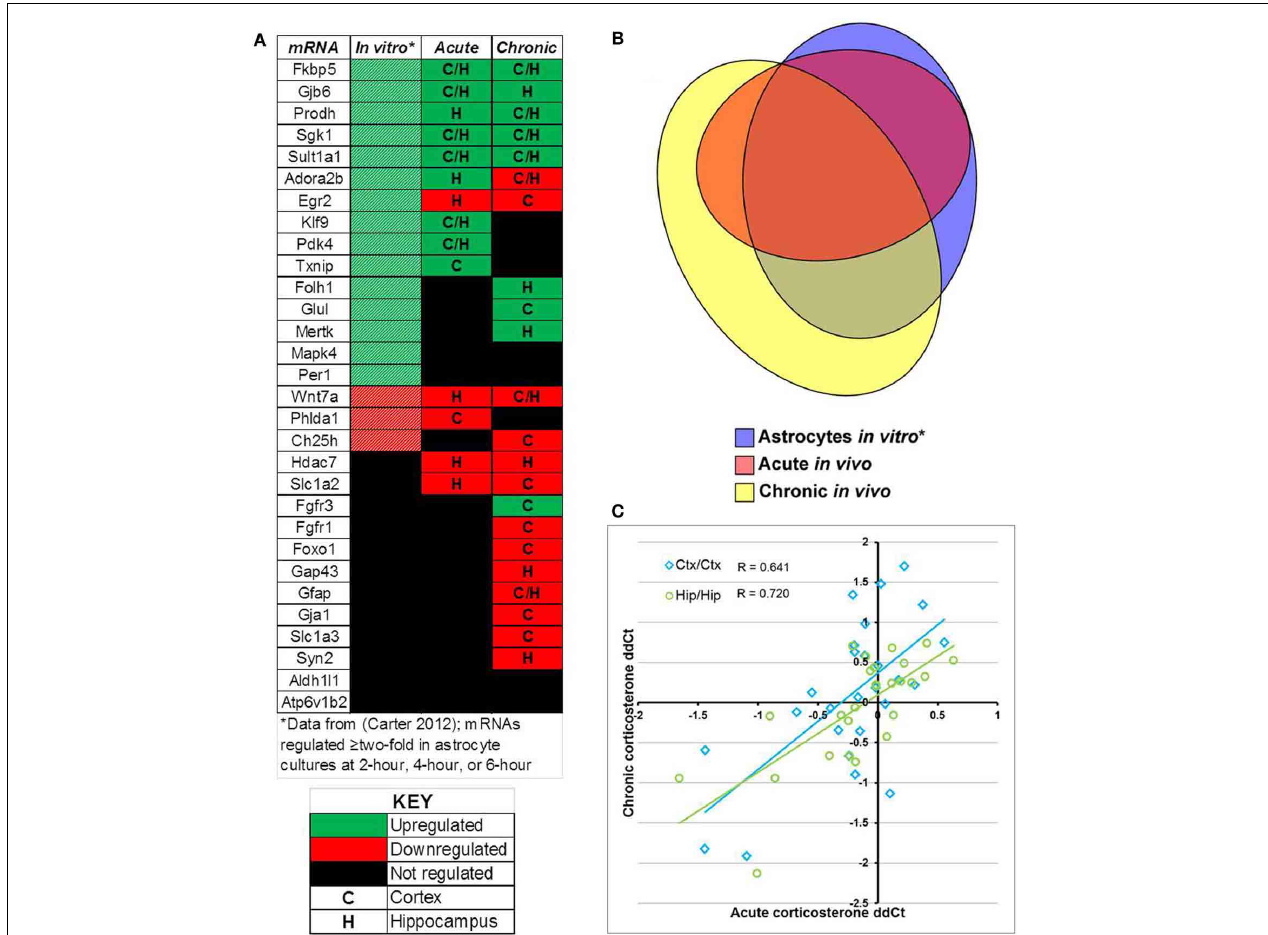
FIGURE 7 | Summary of results for measured mRNAs regarding glucocorticoid regulation by acute corticosterone exposure and chronic corticosterone exposure in vivo . (A) Heatmap summarizing directionality of glucocorticoid regulation of mRNAs across conditions. Key summarizes table terminology. (B) Proportional Venn diagram comparing measured mRNAs regulated by glucocorticoid